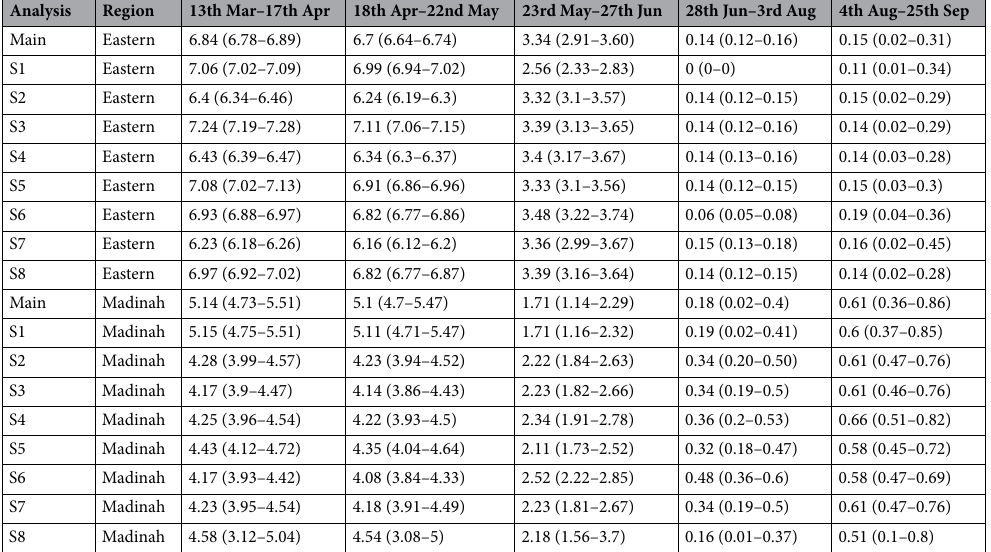
Table 6. Sensitivity analysis of the effective reproduction number R t for Eastern and Madinah.